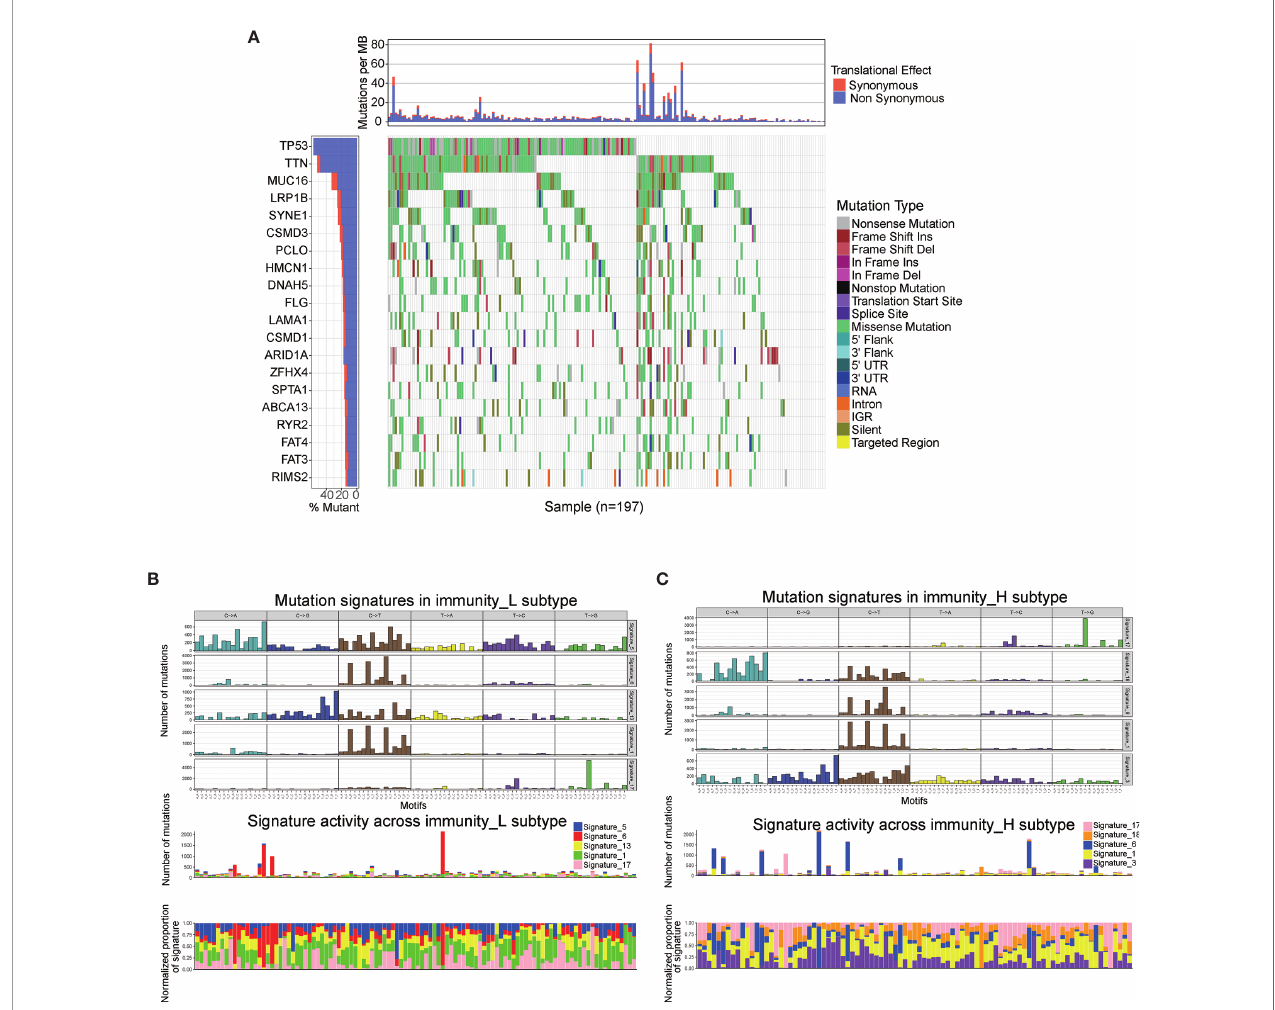
FIGURE 4 | Mutational landscape of SMGs (A) in the TCGA AEG cohort. Mutation patterns (B, C) in the two immune in fi ltration